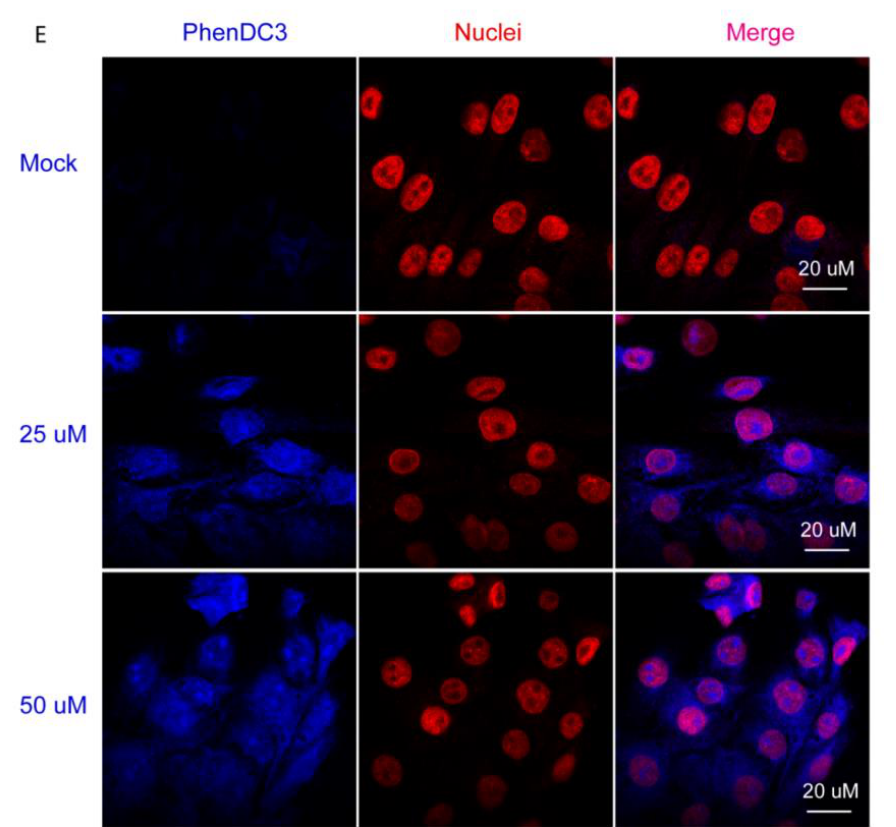
Figure 3. Effect of the G4-stabilizer PhenDC3 on PRV proliferation in PK-15 cells. ( A ) Treating PK-15 cells with increasing concentrations of PhenDC3 for 48 h, the cell viability was assessed by a CCK-8 assay. ( B ) PK-15 cells were pretreated with different concentrations of PhenDC3 (1 µ M–50 µ M) and then infected with PRV HN1201 at an MOI of 1; after incubating with PhenDC3 for 24 h, the viral titer was determined by TCID 50 assay. ( C ) PK-15 cells were treated as in ( B ); the expression level of gE was determined by western blot analysis (representative image). ( D ) PK-15 cells were pretreated with different concentrations of PhenDC3 (1 µ M–50 µ M), and then infected with PRV-GFP (MOI = 0.1); after incubating with different concentrations of PhenDC3 for 24 h, the GFP-positive cells were detected with fluorescence microscopy (top) and quantitatively analyzed by flow cytometry (bottom). ( E ) PK-15 cells were untreated or treated with 25 µ M and 50 µ M PhenDC3 for 1 h, then the cell nuclei were probed with primary antibody Lamin B1 together with Alexa Fluor ® 555 conjugated goat anti-rabbit IgG (H + L). The cells were imaged with a Zeiss LSM 800 Confocal microscopy, λ exc = 405 nm was used for imaging PhenDC3, and λ exc = 561 nm was used for nuclei visualization. All data are shown as mean ± SD based on three independent experiments. *** p < 0.001 determined by one-way